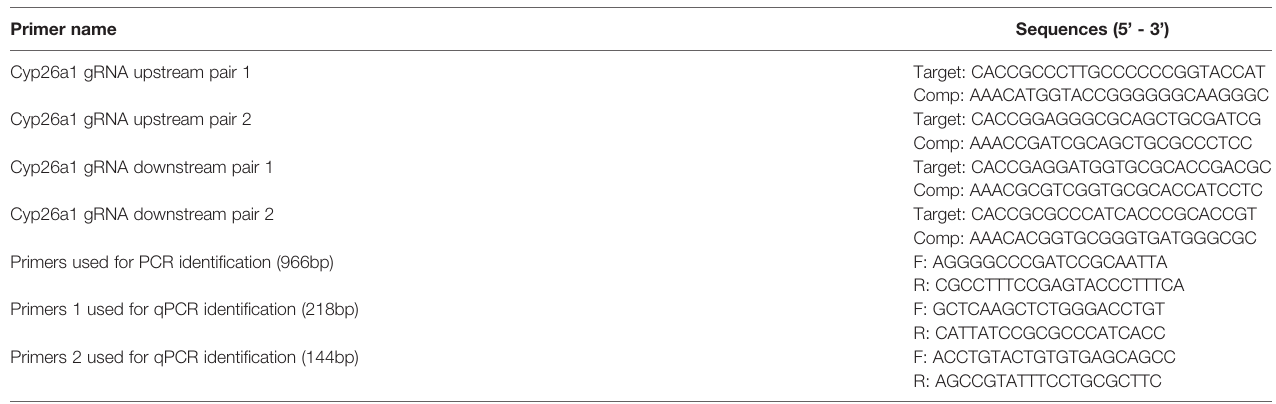
TABLE 1 | Primers used for CRISPR-Cas9-mediated CYP26A1 knockout in Raw264.7. Primer